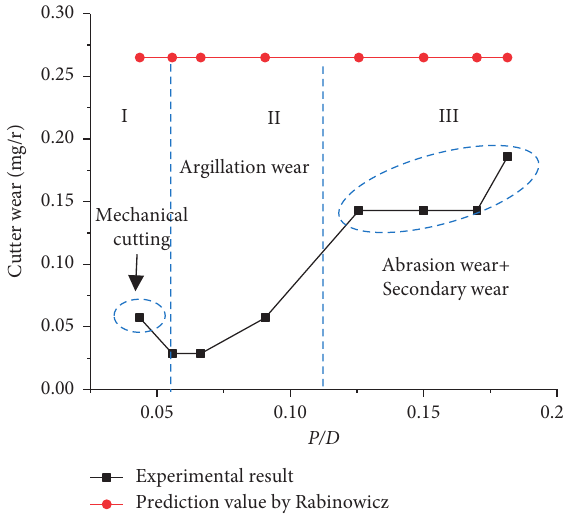
Figure 6: Variation of cutter wear per rotation during the tunnelling process.